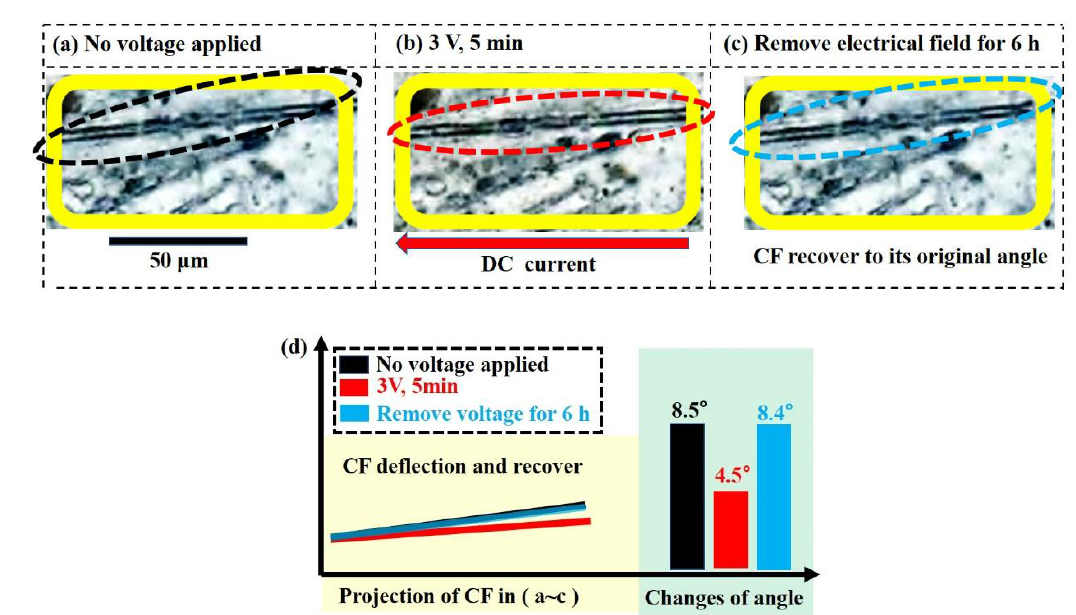
Figure 4. Micromorphology of a fiber: ( a ) no voltage applied, ( b ) under 3 V for 5 min and ( c ) removed electrical field for 6 h. ( d ) Projection of the carbon fiber in ( a – c ) and the changes of the corresponding angle.